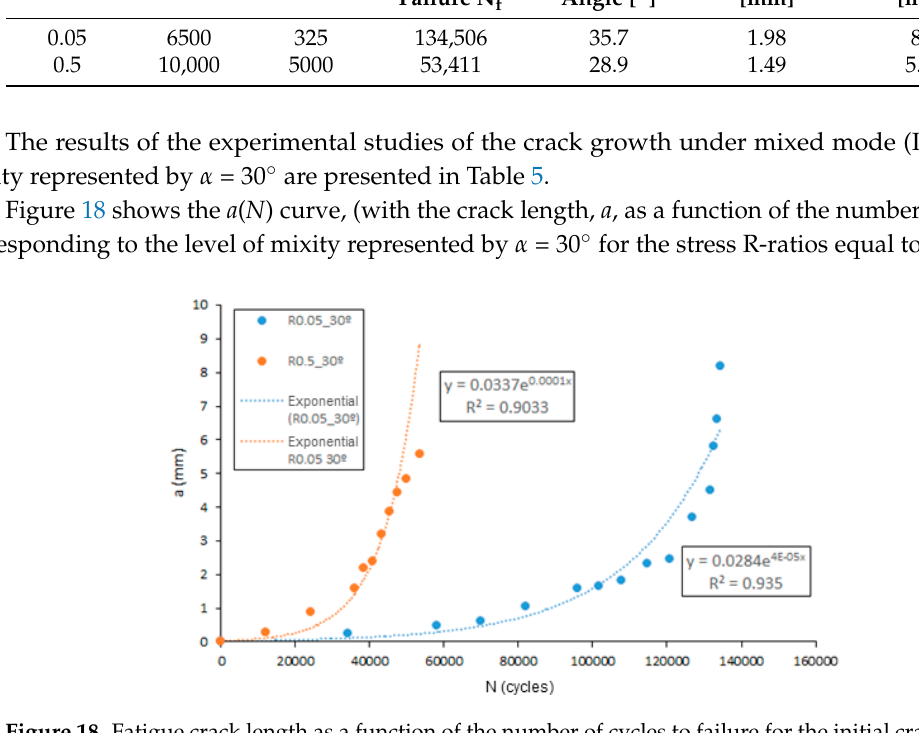
Figure 18. Fatigue crack length as a function of the number of cycles to failure for the initial crack angle of α = 30 ◦ and stress ratios of R = 0.05 and